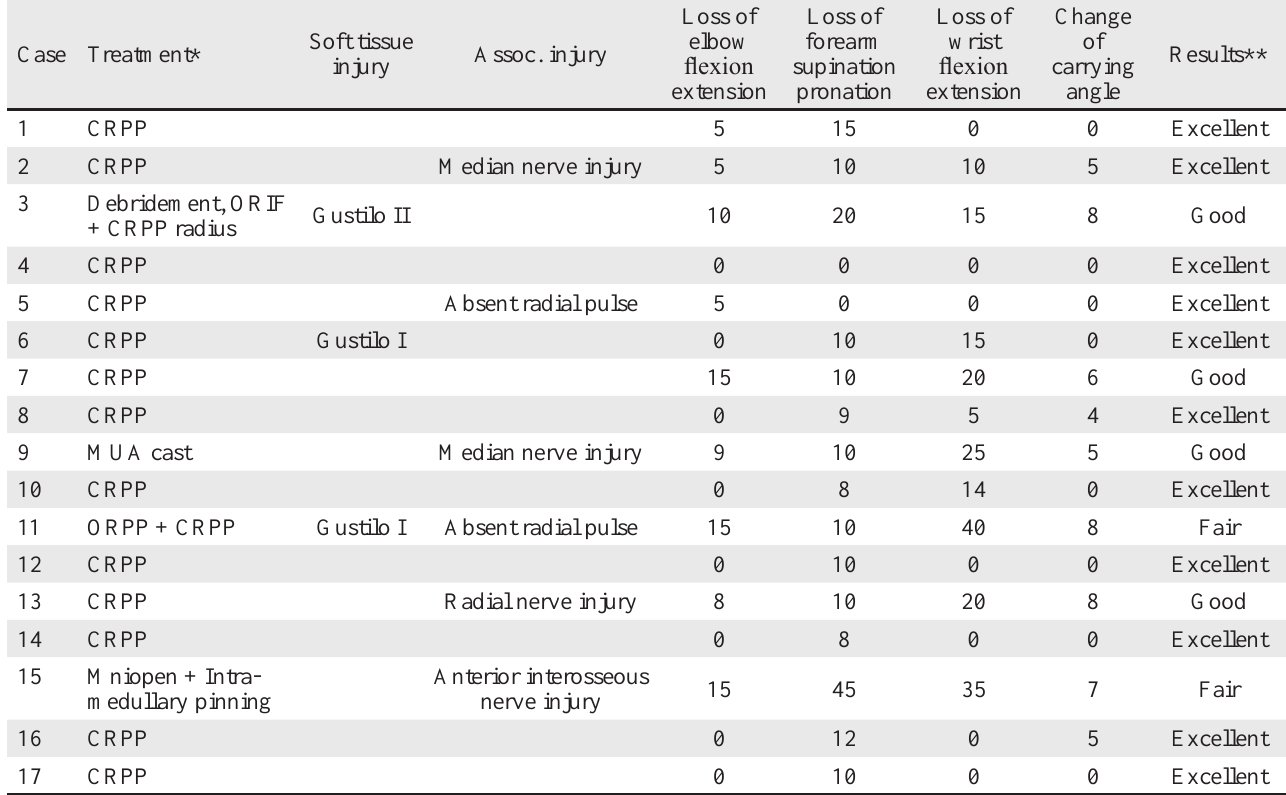
4: Treatment and assessment outcomes in 17 patients